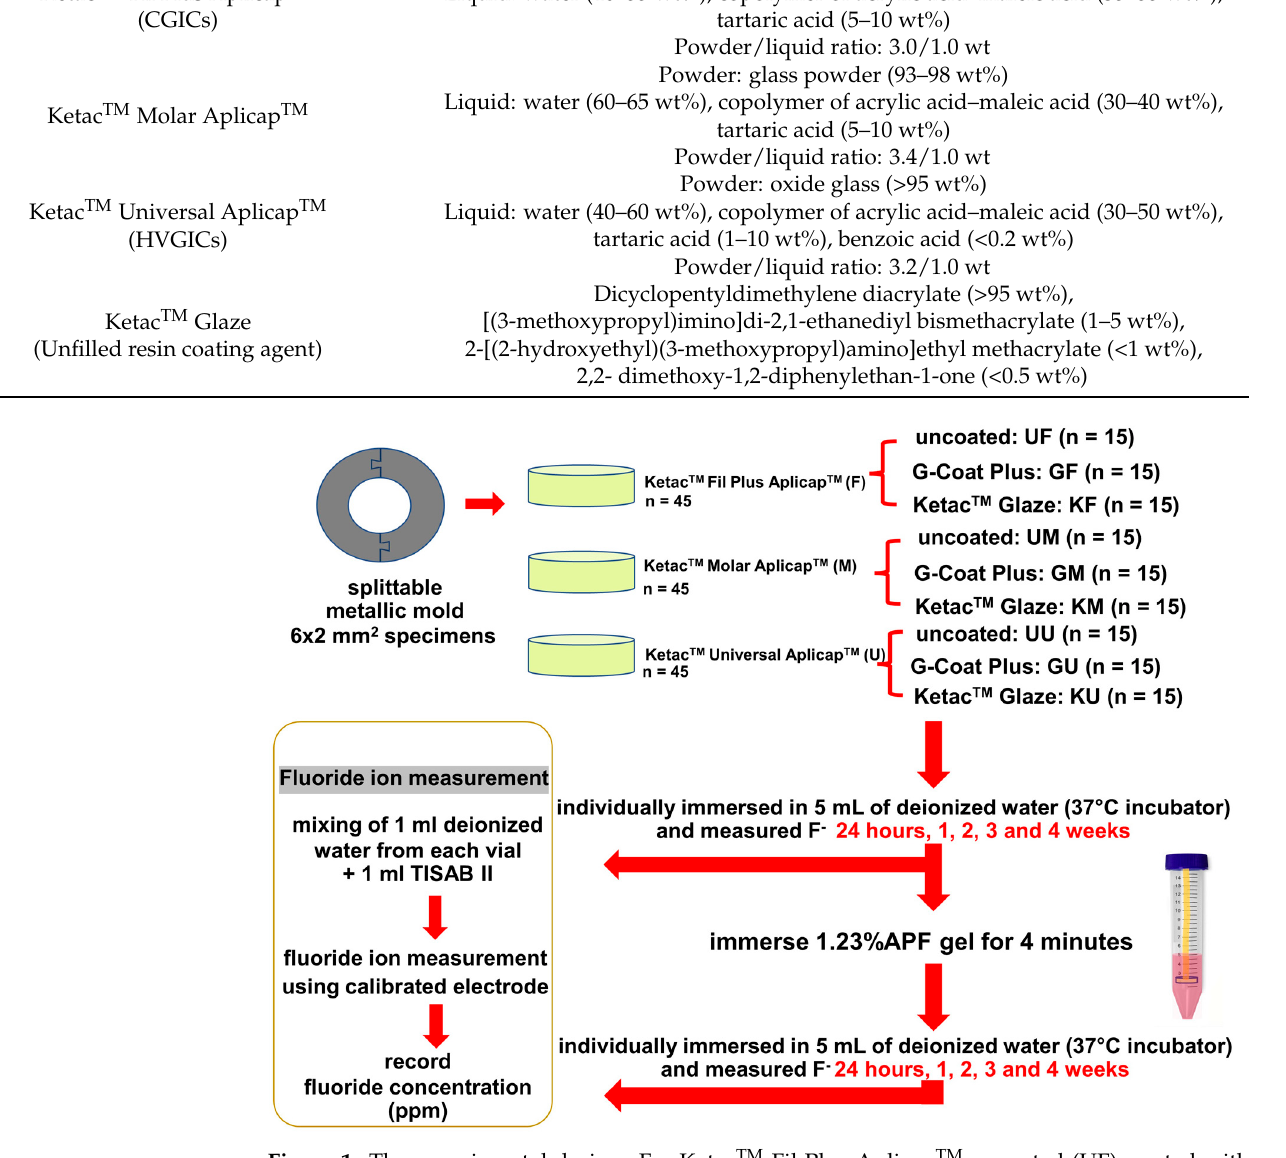
Figure 1. The experimental design. F = Ketac TM Fil Plus Aplicap TM uncoated (UF), coated with G-Coat Plus (GF), and coated with Ketac TM Glaze (KF); M = Ketac TM Molar Aplicap TM uncoated (UM), coated with G-Coat Plus (GM), and coated with Ketac TM Glaze (KM); U = Ketac TM Universal Aplicap TM (U) uncoated (UU), coated with G-Coat Plus (GU), and coated with Ketac TM Glaze (KU). The metallic mold was placed on a glass slide covered with a celluloid strip and filled with the test materials, following the manufacturer’s instructions. All of the materials were immediately covered with a new celluloid strip, followed by the glass slide, and pressed with a 200-g stainless steel standard weight for seven minutes to enable the early